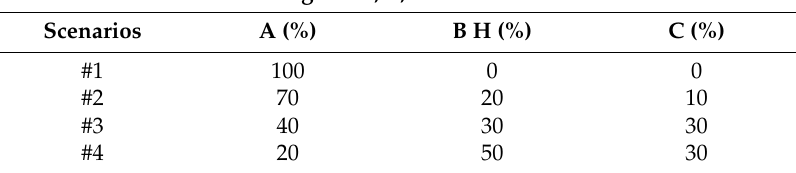
Table 1. Hypothesis of the stored goods in the warehouse over the time, according four different scenarios corresponding to different mix of ABC classes.